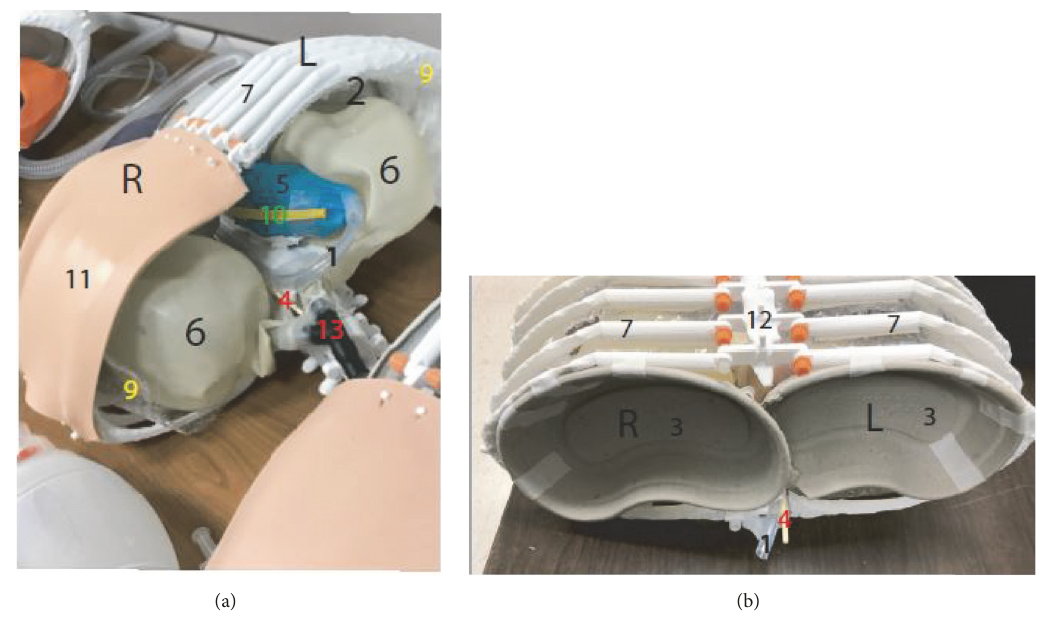
Figure 1: 1= Aorta. 2= Chest cavity. 3= Diaphragm. 4= Esophagus. 5= Heart with pericardium. 6= Lung. 7= Rib. 8= Rib spreader. 9= Parietal pleura. 10= Phrenic nerve. 11= Skin with subcutaneous tissue and chest wall muscle. 12= Sternum. 13= Trachea with main bronchi. L= left side. R= right